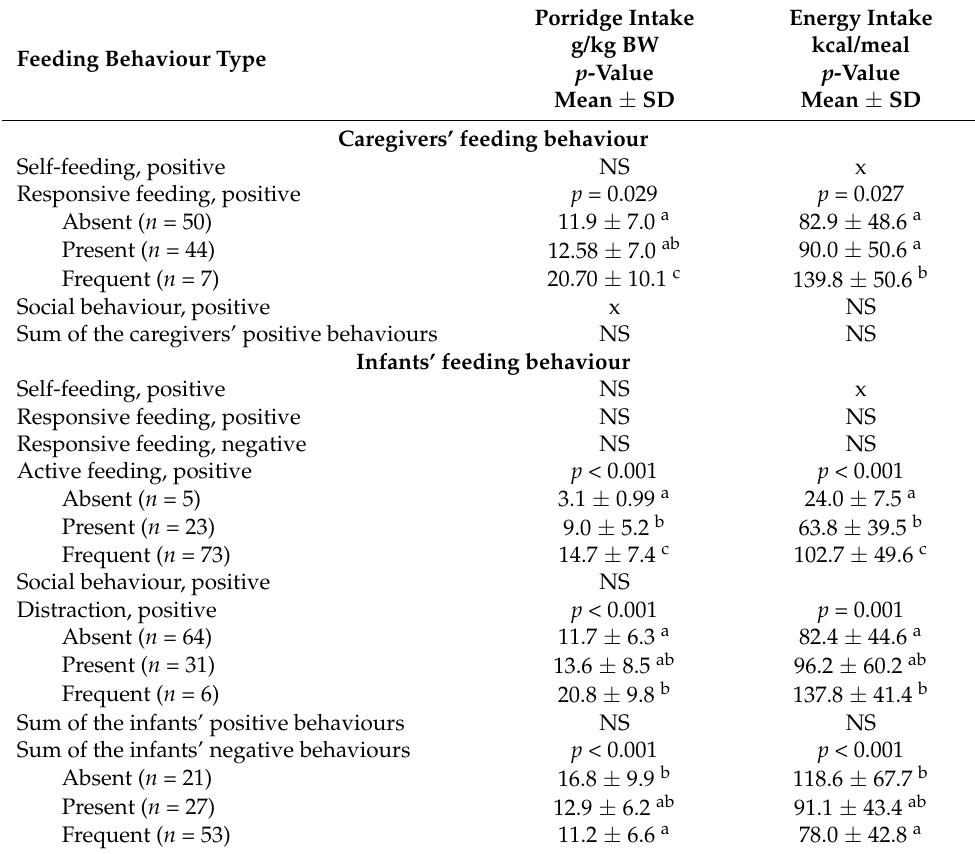
Table 7. Feeding behaviours significantly associated with the children’s porridge and energy intakes and adjusted means: multivariate